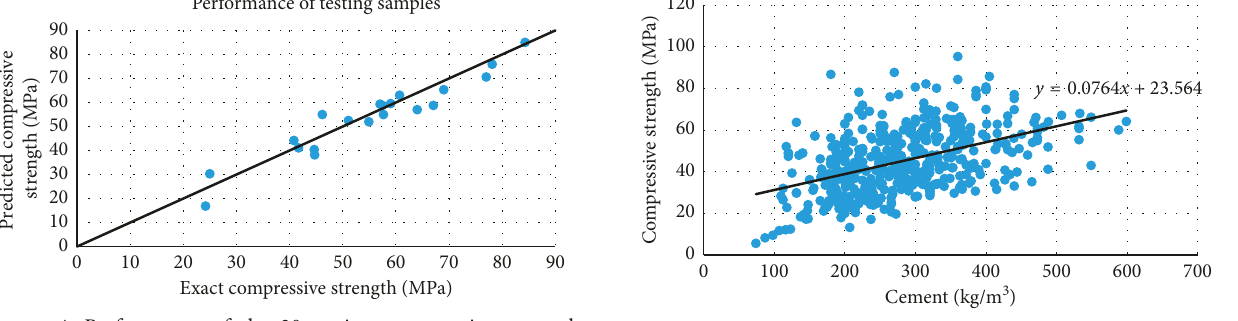
Figure 7: Distribution of compressive strength and cement for the training samples of the CSPNN.